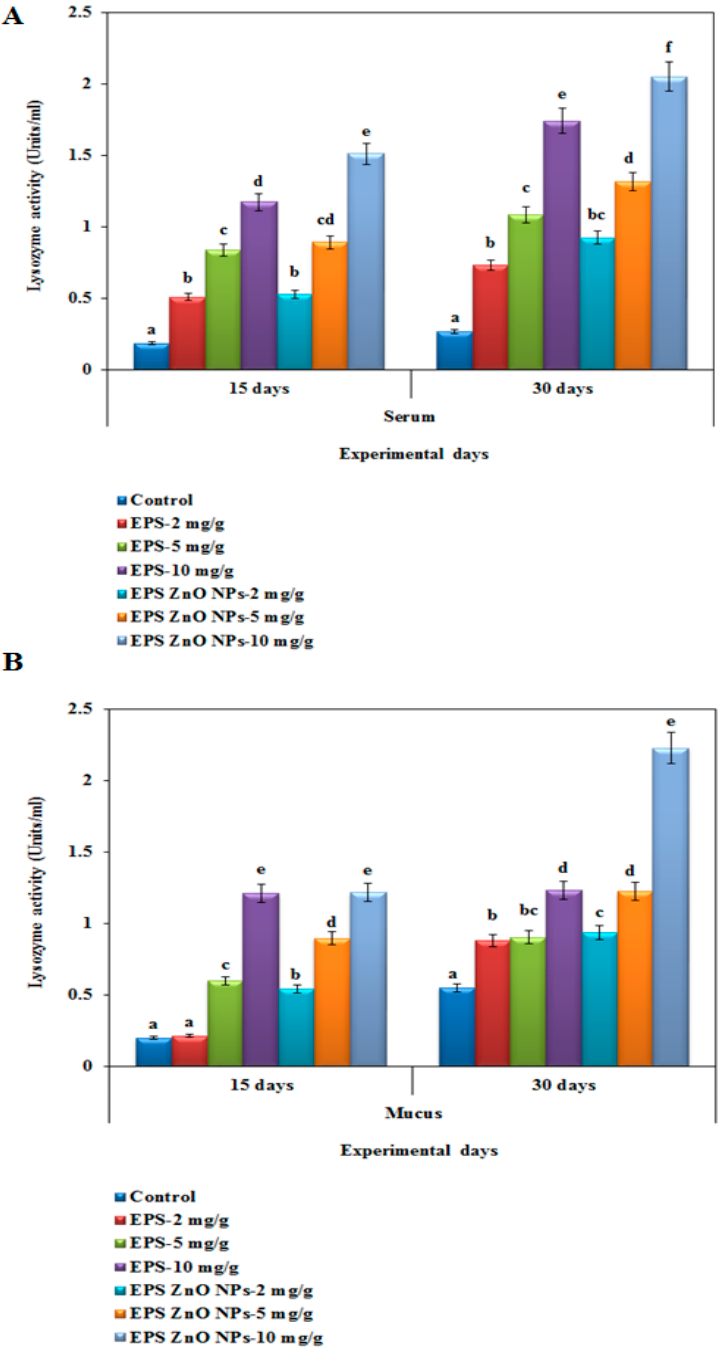
Figure 5. Lysozyme activity of O. mossambicus fed with EPS and EPS-ZnO NPs: ( A ) serum and ( B ) mucus. T-bars indicate three replicates of mean ± SD, and different letters correspond to the statistical difference between treated groups.